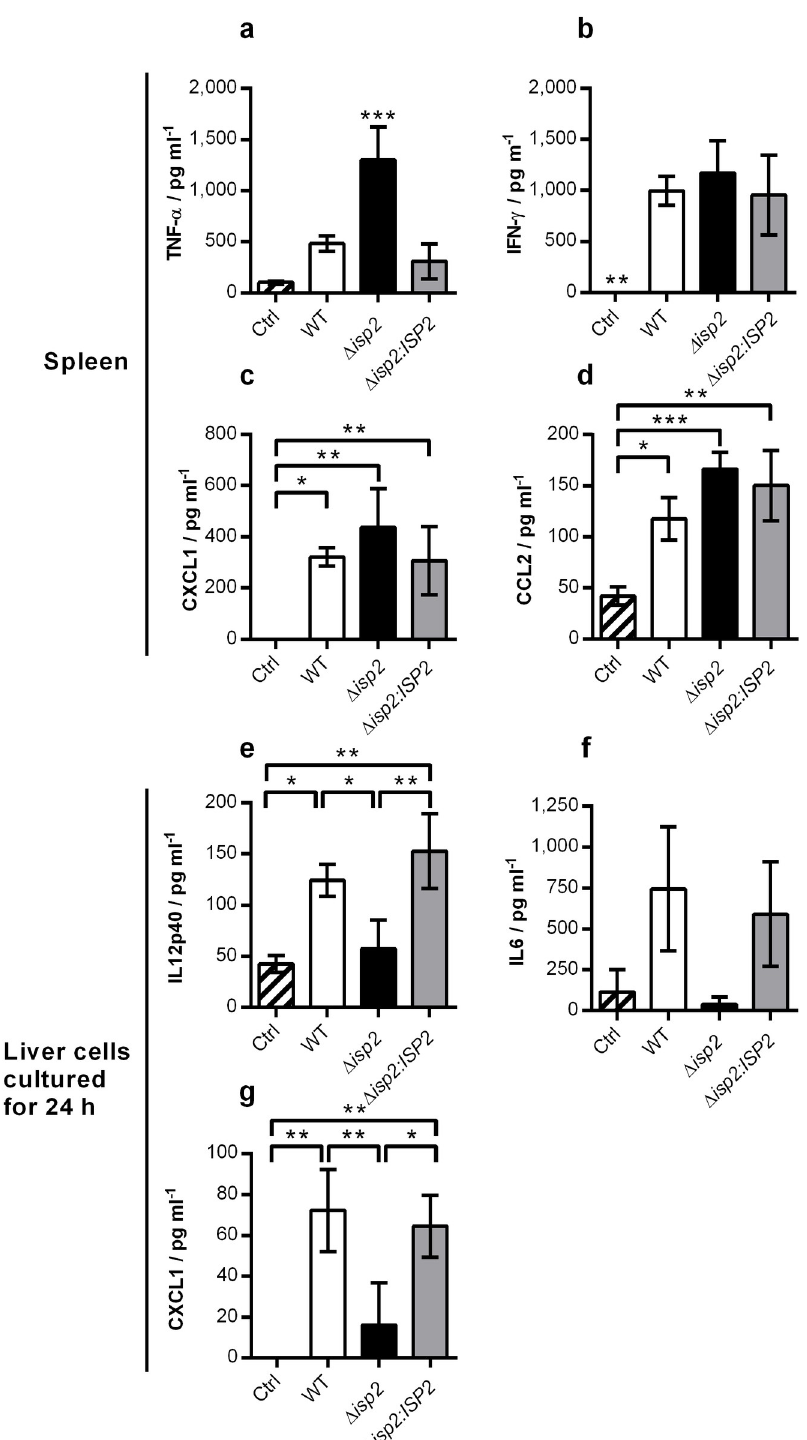
Fig 8. Cytokine levels in spleen and liver of infected mice. C57BL/6 mice were infected intraperitoneally with 1 × 10 5 T . b . rhodesiense WT, Δ isp 2 and Δ isp 2: ISP 2.Uninfected mice were used as a control (Ctrl). After 4 days, mice were euthanized and perfused. The spleens and livers were removed and homogenized. Spleens were centrifuged and the supernatants were collected. The concentrations of (a) TNF- α , (b) IFN- γ , (c) CXCL1 and (d) CCL2 were assessed by ELISA. The cell suspensions from the liver were normalized for volume in relation to organ weight and cultured for